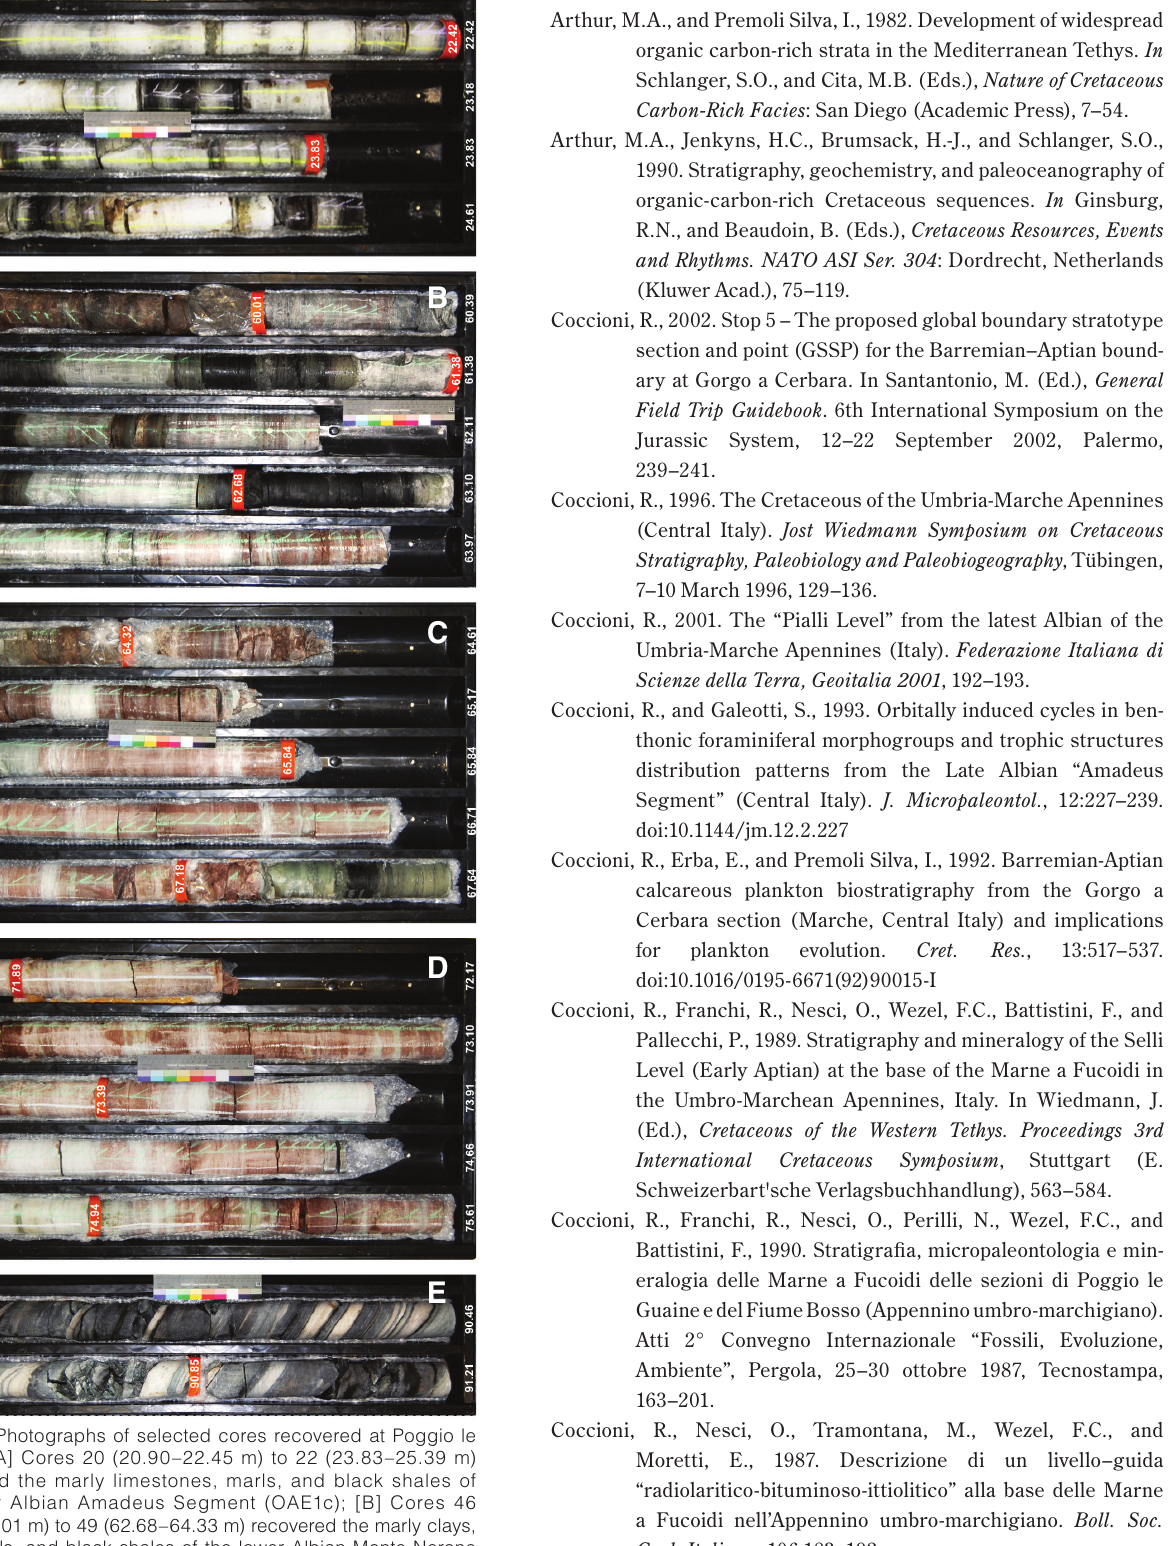
and Kilian Levels (OAE1b); [C] Cores 49 (62.68–64.33 m) to 52 (67.18–68.77 m) penetrated latest Aptian marls and calcareous marls together with the black shales of the uppermost Aptian Jacob Level (OAE1b); [D] Cores 54 (70.32–71.89 m) to 57 (74.94–76.45 m) recovered late Aptian marls, marly clays, and calcareous marls; [E] Cores 66 (88.00–89.60 m) to 68 (90.85–91.99 m) penetrated the lower Aptian Selli Level